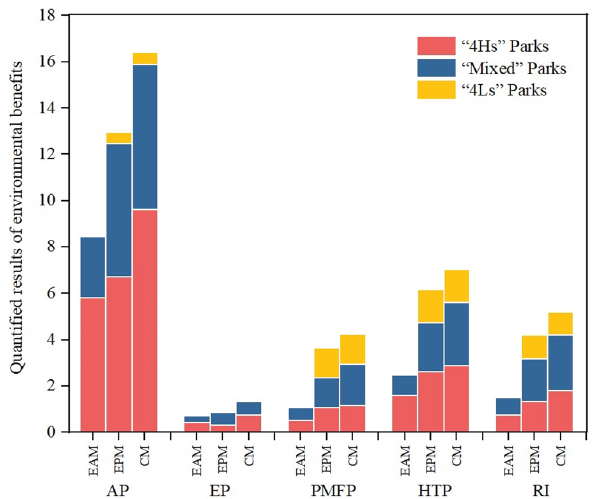
Figure 7. Five environmental benefits brought by three emission reduction measures. AP: acidification potential, kt SO 2 eq; EP: eutrophication potential, kt PO 4 3− eq; PMFP: particulate matter formation potential, kt PM 10 eq; HTP: human toxicity potential, kt 1-4-DCBeq; RI: respiratory inorganics, kt PM 2.5